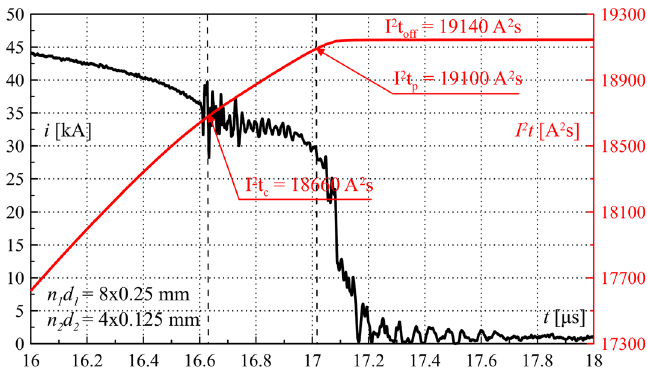
Figure 16. TSFF current i F and Joule integral I 2 t waveforms during operation—laboratory test results. Characteristic values are marked in the figure. Close-up on the commutation and the current limiting process.